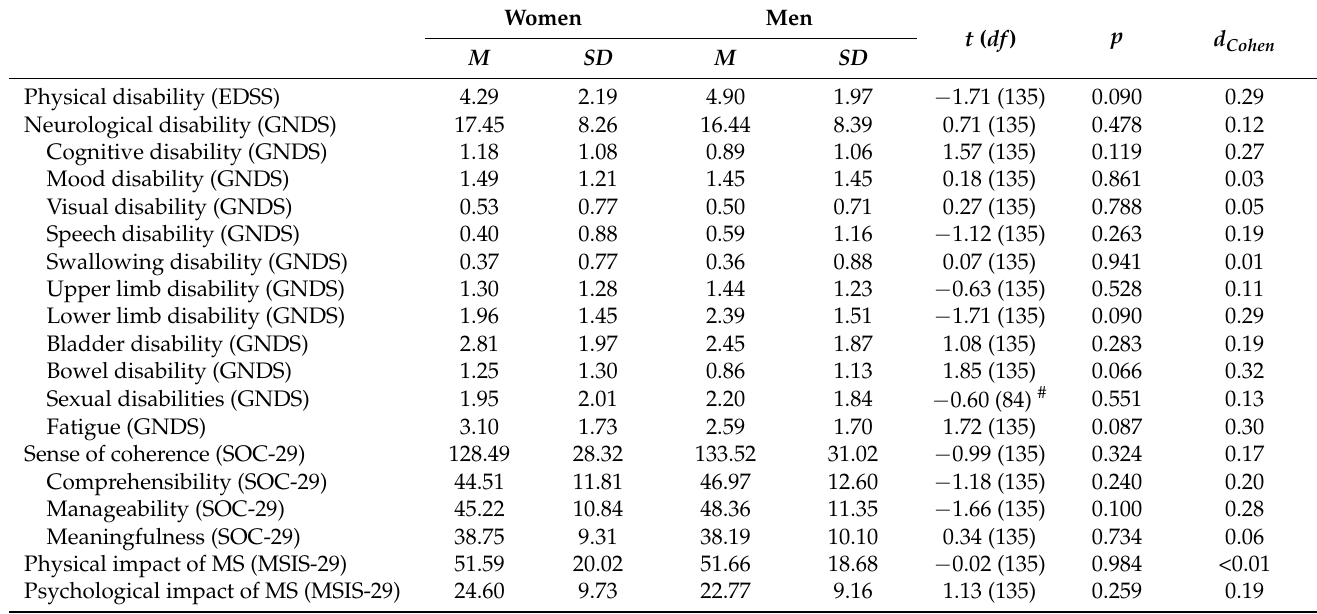
Table 3. Results of the t -test